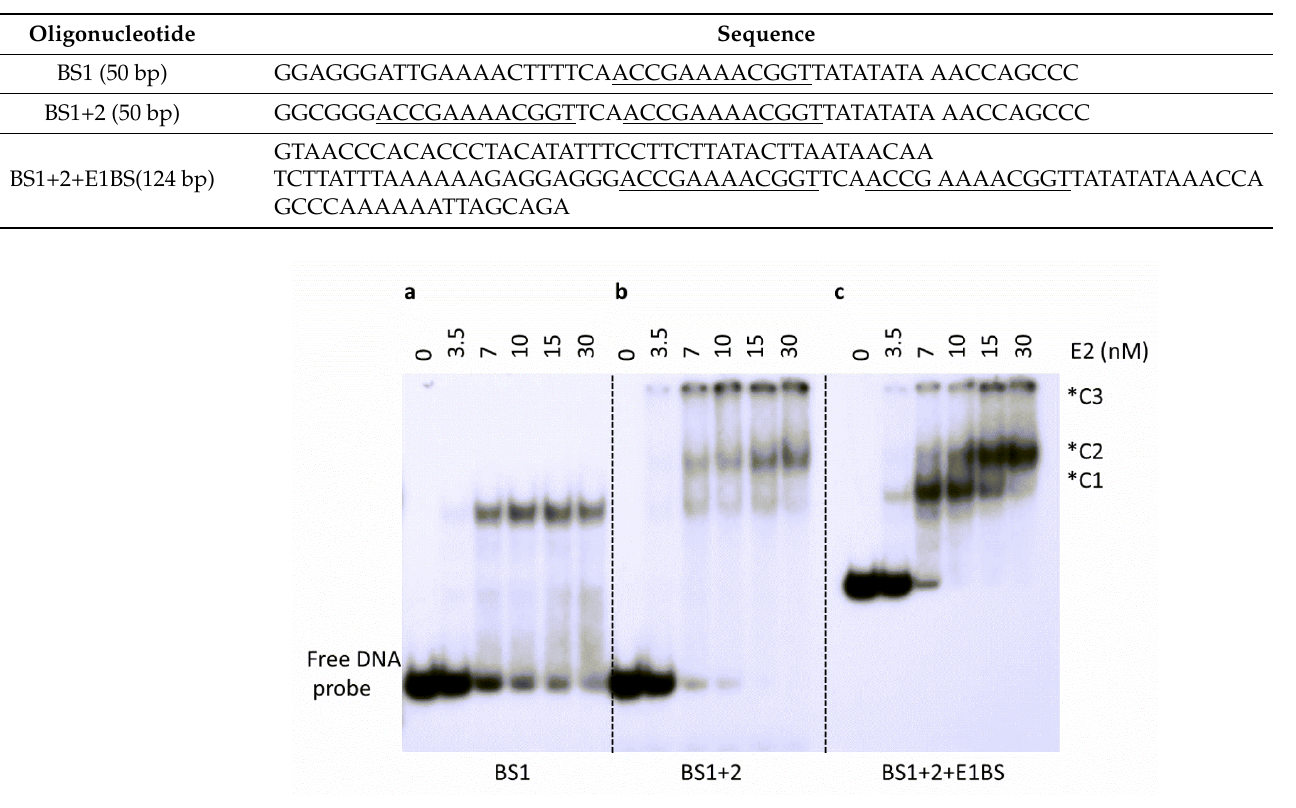
Figure 8. Analysis of multi-site DNA binding of E2 protein. E2 DNA binding studies with ( a ) oligonucleotides containing E2 BS1 alone (BS1), ( b ) containing both BS1 and BS2 (BS1+2), or ( c ) containing BS1, BS2, and E1 binding site (BS1+2+E1BS). EMSA was performed with increasing amounts of E2 protein as indicated above each lane. *C1 indicates a complex with one E2 dimer, *C2 indicates a complex with two E2 dimers and *C3 refers to a complex containing more than two E2 dimers. Oligonucleotide sequences are presented in Table 3. Table 3. Sequences of oligonucleotides utilized in multi-site DNA binding assays. Sequences for only one strand of each duplex oligonucleotide are shown. E2 binding sites (BS1 and BS2) are un- derlined and bolded.